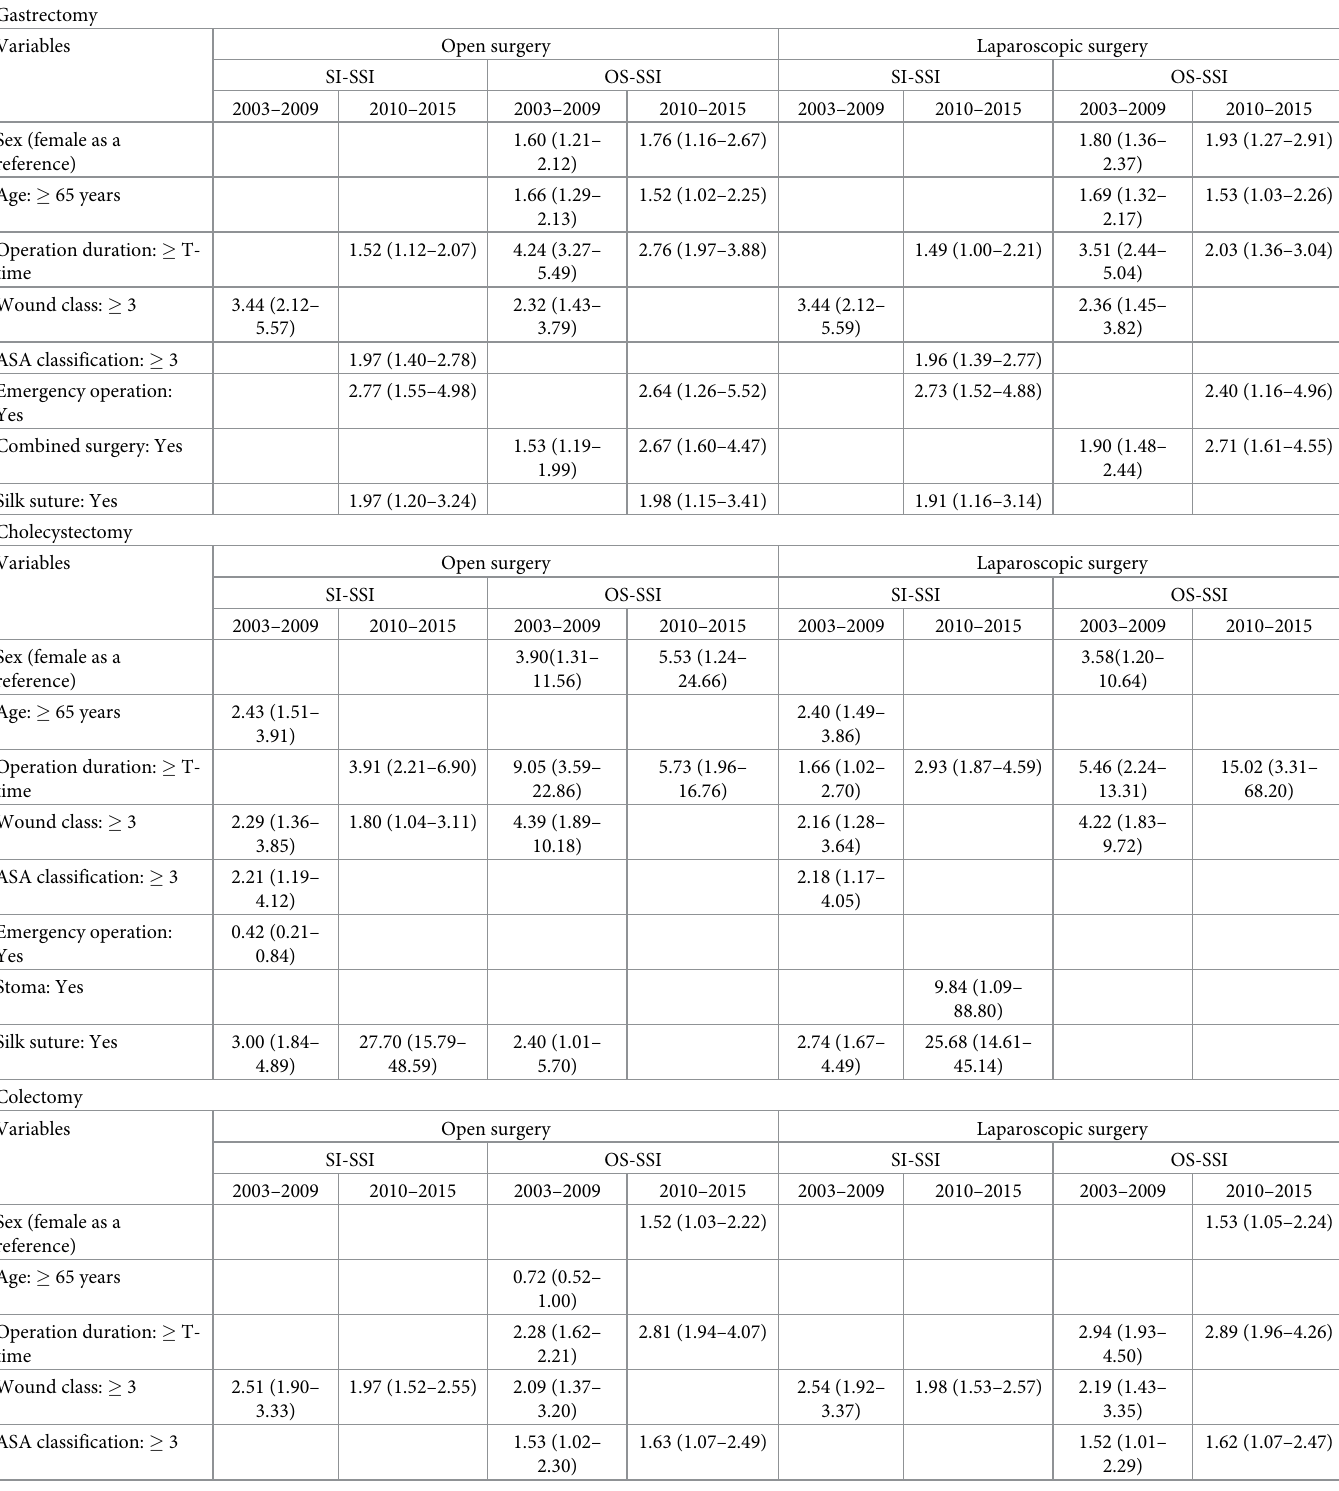
Table 2. Multiple logistic regression analysis of SSI risk factors by surgical procedure: SI-SSI and OS-SSI.